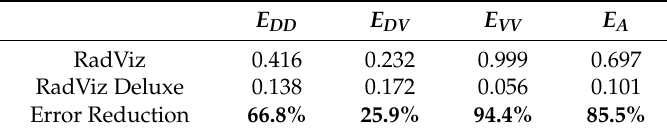
Table 2. RadViz vs. RadViz Deluxe in terms of the various layout errors.